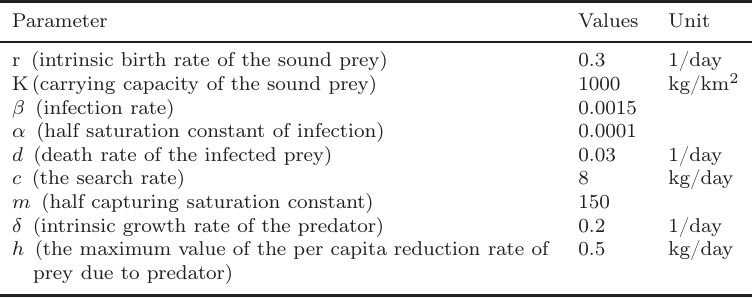
Table 1. Parameter values used for